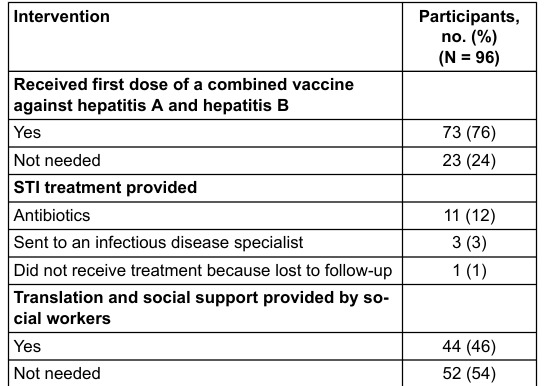
Table 4: Medical and social interventions provided during the study. The study was performed from 1 April 2015 to 31 December 2016 in Lausanne, Switzerland. Intervention Participants,